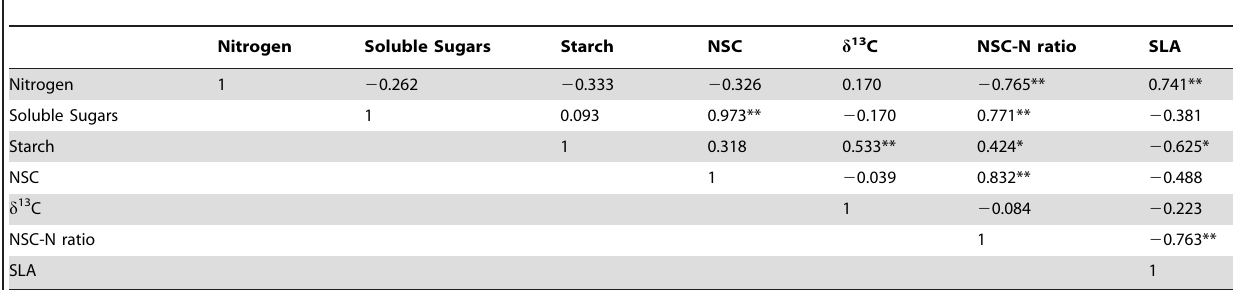
Table 4. Correlation coefficients among NSC (non-structural carbohydrates), soluble sugars, starch, nitrogen contents, NSC-N ratio, d 13 C contents, and SLA for Pinus koraiensis